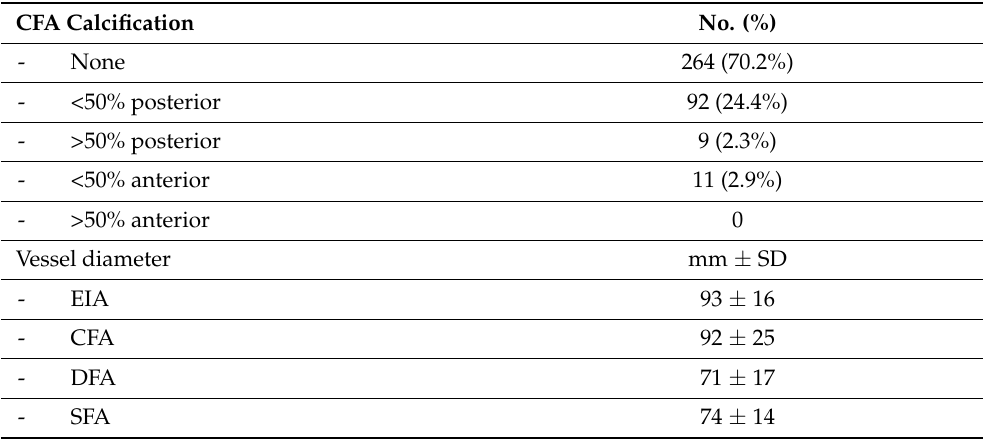
Table 2. Vessel characteristics. CFA = common femoral artery; No. = number; SD = standard deviation; EIA = external iliac artery; DFA = deep femoral artery; SFA = superficial femoral artery; calcification levels according to Manunga et al.